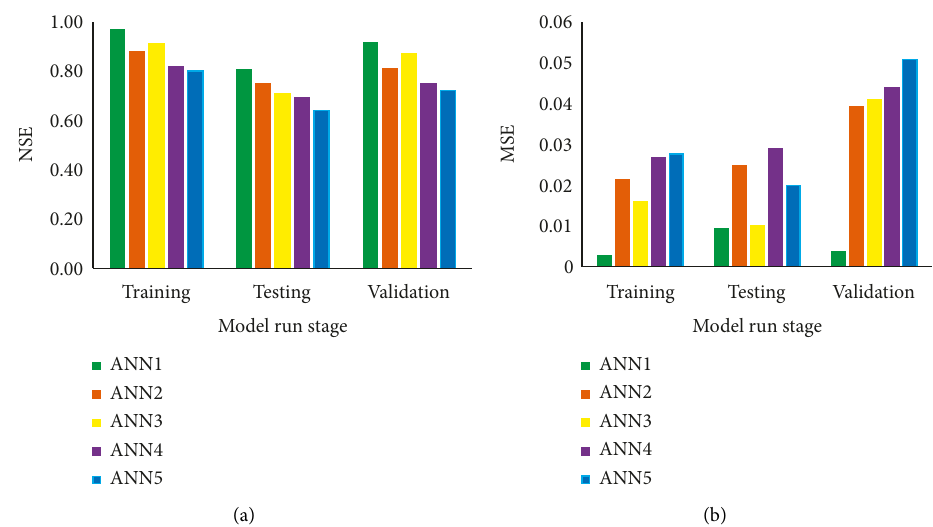
Figure 8: ANN model results. (a) The values of NSE. (b) The values of MSE.